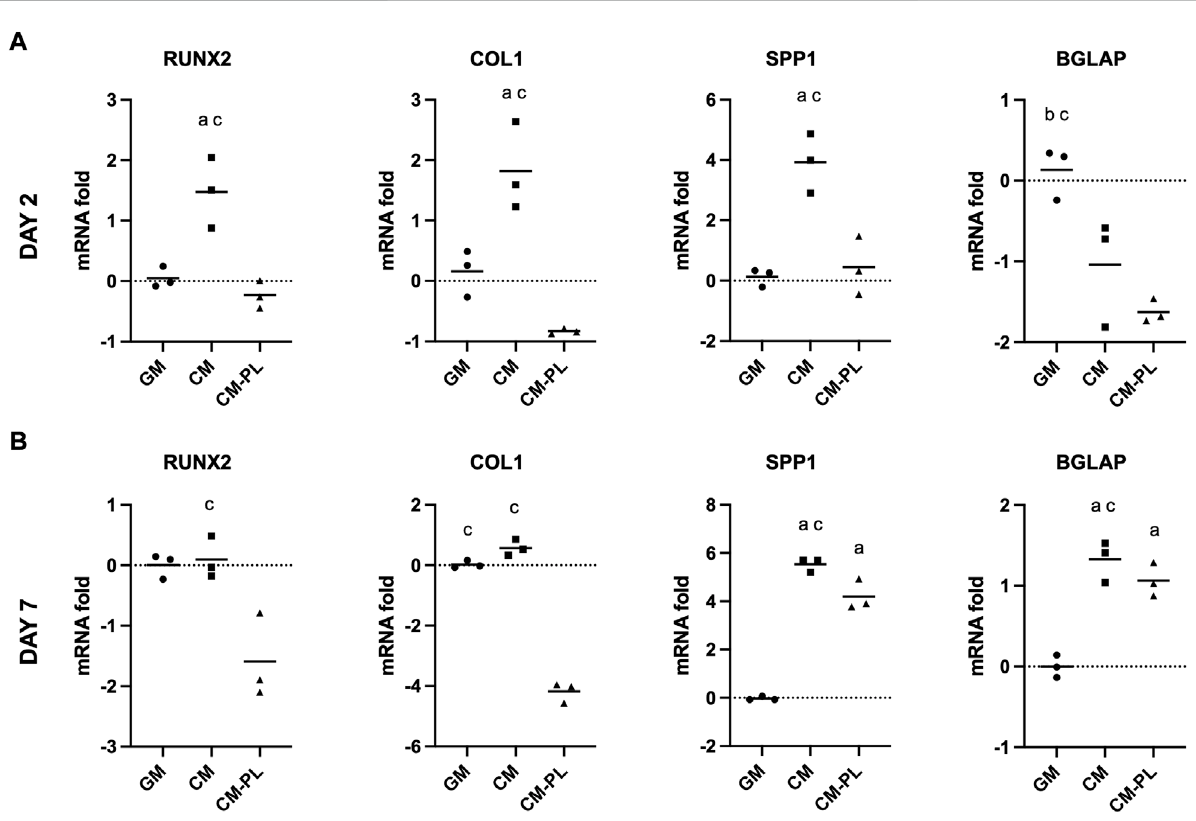
FIGURE 2 Osteogenic gene expression. Relative mRNA fold changes in BMSC after 2 (A) and 7 days (B) . Data indicate means of 3 experimental replicates for BMSC from one representative donor [Log(2)-transformed y-axis; negative values indicate gene downregulation]. Signi fi cance ( p < 0.05) is denoted by alphabetical letterings: a, compared to GM; b, compared to CM; c, compared to CM-PL; GM, growth media; CM, conditioned media; conditioned media with platelet